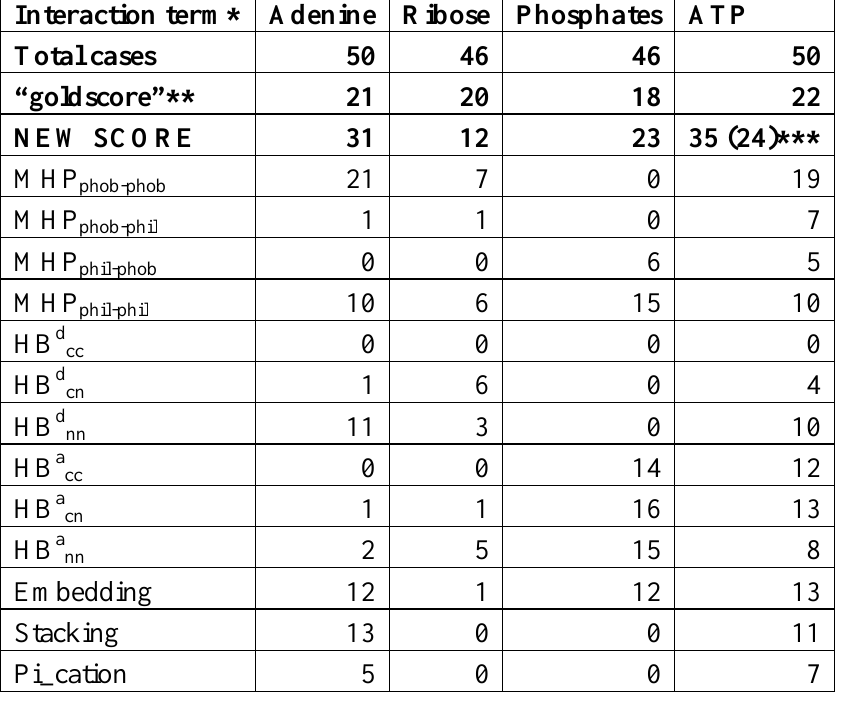
Table 1. Results of docking and scoring (hit